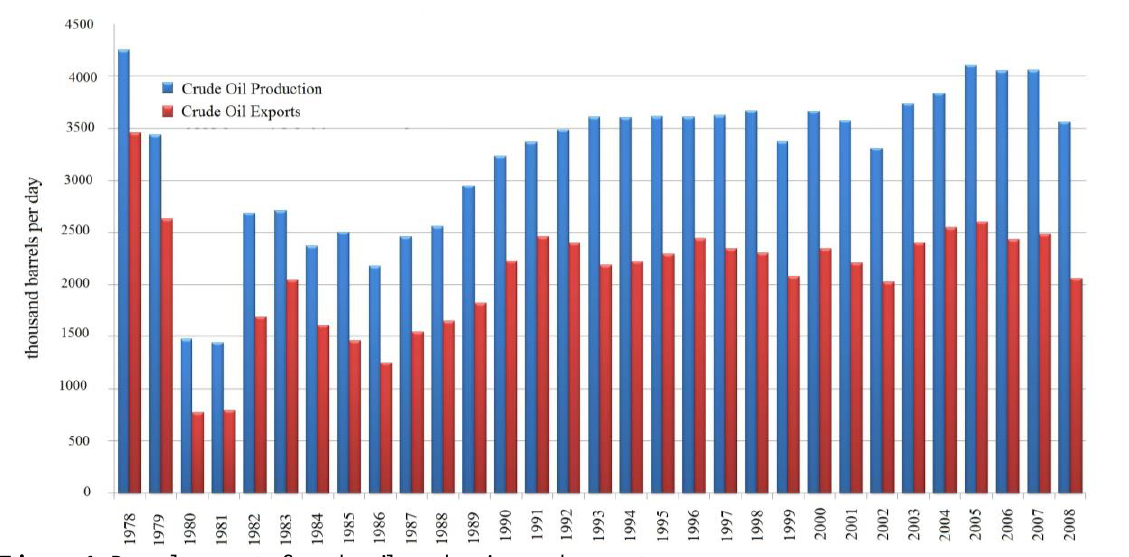
Figure 1. Development of crude oil production and